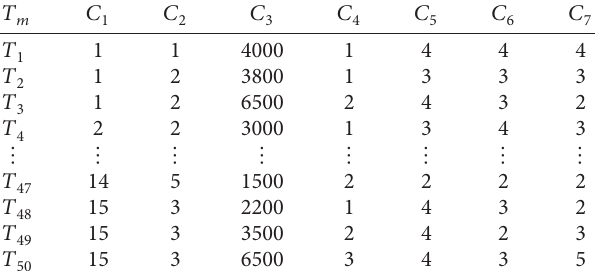
� [ d ] for tenants’ housing ij 1 1 50 × 50